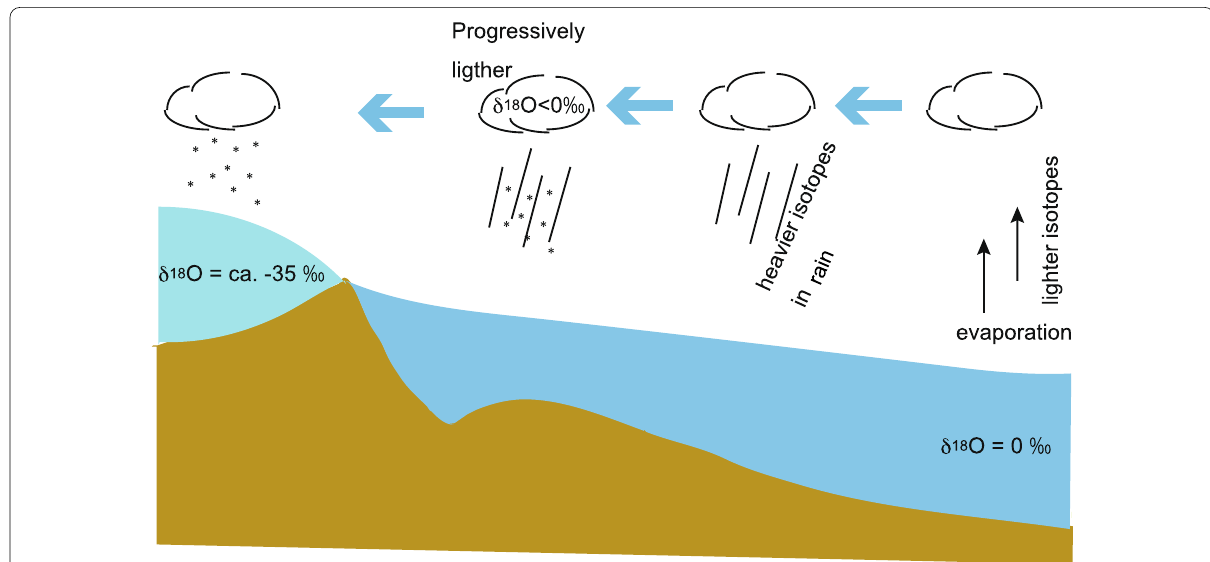
Fig. 2 Cartoon showing the hydrological cycle of the Earth causing δ 18 O changes in precipitation at different latitudes. Because of these processes, polar ice sheets hold relatively lighter isotopes of oxygen in ice as much as 3–5% compared to the open